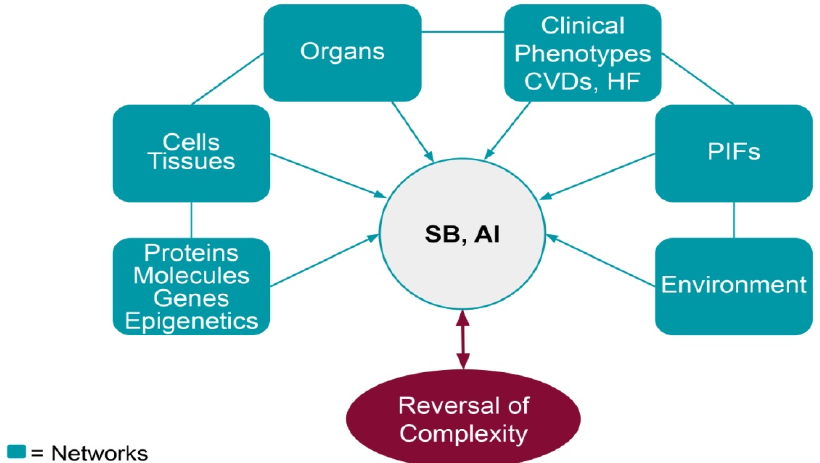
Figure 6. Schematic diagram based on the SB concept of communication (links and data transmission) between sub-clinical and clinical stages of chronic complex cardiac diseases (CVDs and HF). The reversal of CVDs and HF phenotypes depends on data transmission (SB holistic principle) and AI (focused on human medical data). SB = systems biology; AI = artificial intelligence; CVDs = cardiovascular diseases; HF = heart failure; PIFs = phenotype influencing factors. Clinical phenotypes reversal is a potentiality that depends on research carried out in large populations of CVD and HF patients. Such an approach requires a large amount of relative data using a multiomics approach and network analysis in order to embrace the concept of complexity. Analysis of this data will help to understand the complexity of chronic heart diseases and explain the interrelationship and interconnection between their biological networks in order to achieve improvement in the prospects for reversal of clinical phenotypes.